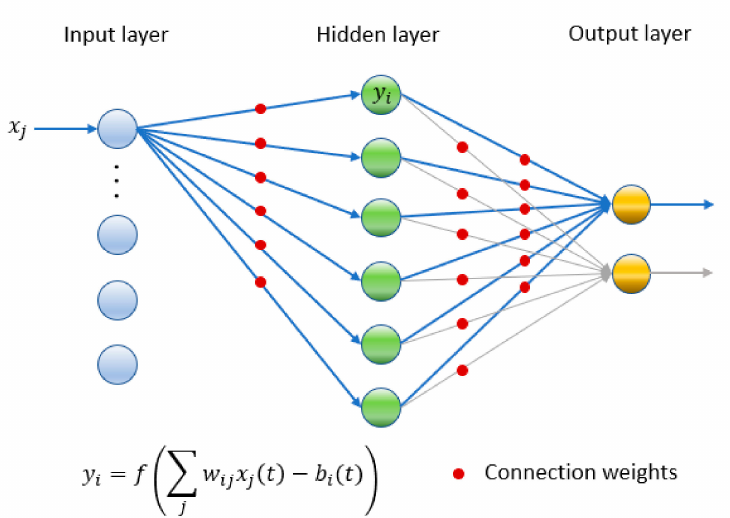
Figure 3. Example of Multi-Layer Perceptron topology, where connections for neurons of consecutive layers are characterized by weights. The output of each layer is produced by the application of an activation function in the lineal combination of the inputs and the weights. The output is obtained with the response given by the output layer, after the sequences of hidden